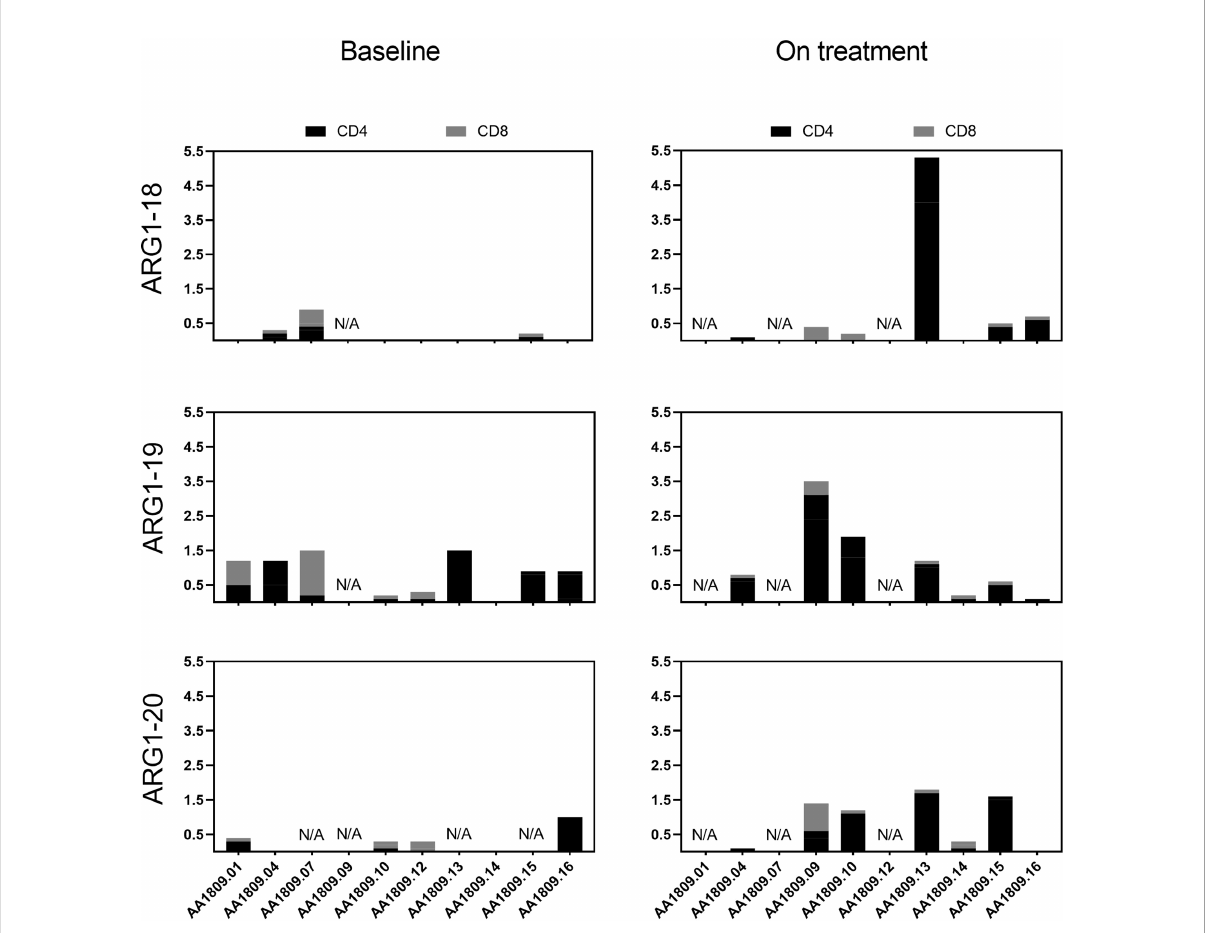
FIGURE 3 CD4+ and CD8+ arginase-1 (ARG1) vaccine-speci fi c T cell responses in blood. Total ARG1-speci fi c CD4+ (black) and CD8+ (grey) T cell responses in peripheral blood mononuclear cells (PBMCs) at baseline and on treatment. The data were quanti fi ed by fl ow cytometry by an increased expression of interferon (IFN) g , IFN g + TNF a , and TNF a after fi ve-hour peptide stimulation. A detailed cytokine expression pro fi le is shown in Supplementary Figure 1. The values indicate speci fi c responses subsequent to substraction of background values (n=10). N/A, Not